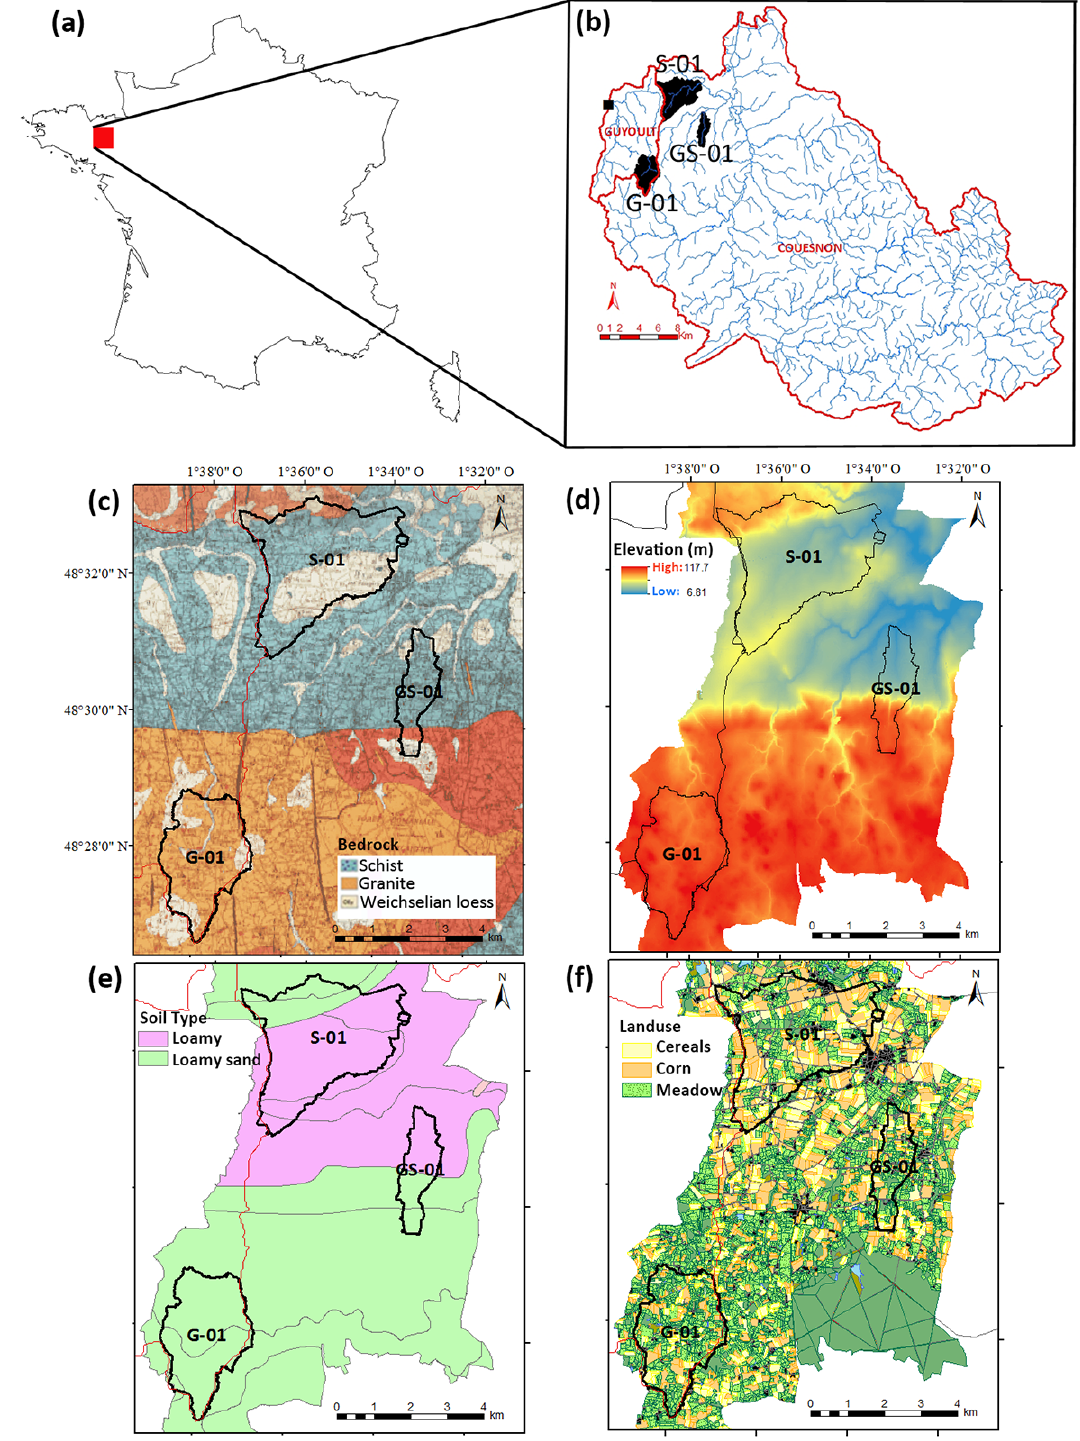
Figure 1. Location and physical characteristics of the three study catchments. Panel (a) : the red square delineates the Zone Atelier Armorique LTER on the map of France. Panel (b) : the catchment G-01 is a subcatchment of the Le Guyoult basin (gauged outlet indicated by black square). The two catchments GS-01 and S-01 are subcatchments of the Couesnon basin. Panel (c) : geological overview showing granite in the south and schist in the north. Panel (d) : digital elevation model from lidar with a 2m resolution; elevation given in m.a.s.l. Panel (e) : land use from the last year of study period (i.e., 2000). Panel (f) : map of soil